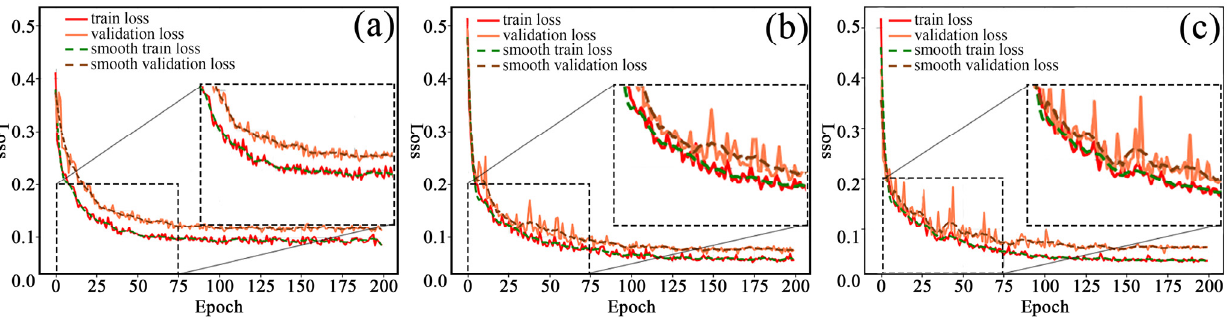
Figure 9. Different model training loss curves: ( a ) UNet model; ( b ) PSPNet model; ( c ) DeepLab _ v3+